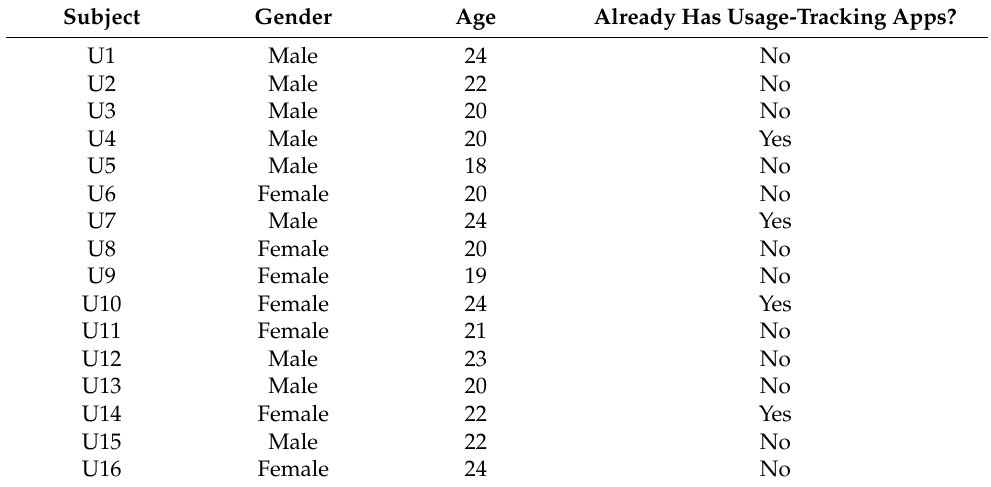
Table 2. Participants’